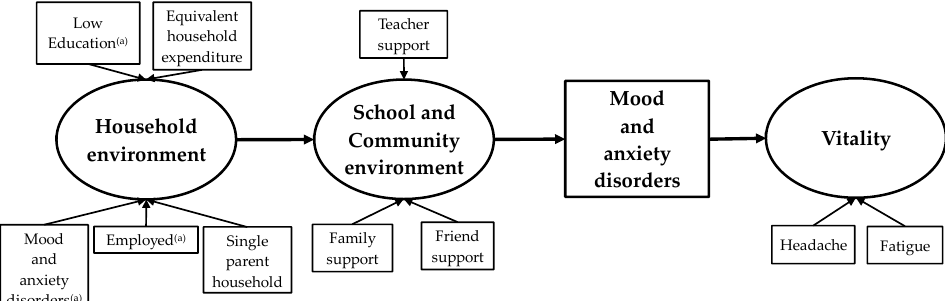
Figure 1. Applied ecological model of effects of household, school, and community environments on adolescent mental health. Measurement items for mood and anxiety disorders and error variance are not shown. (a) Household head.